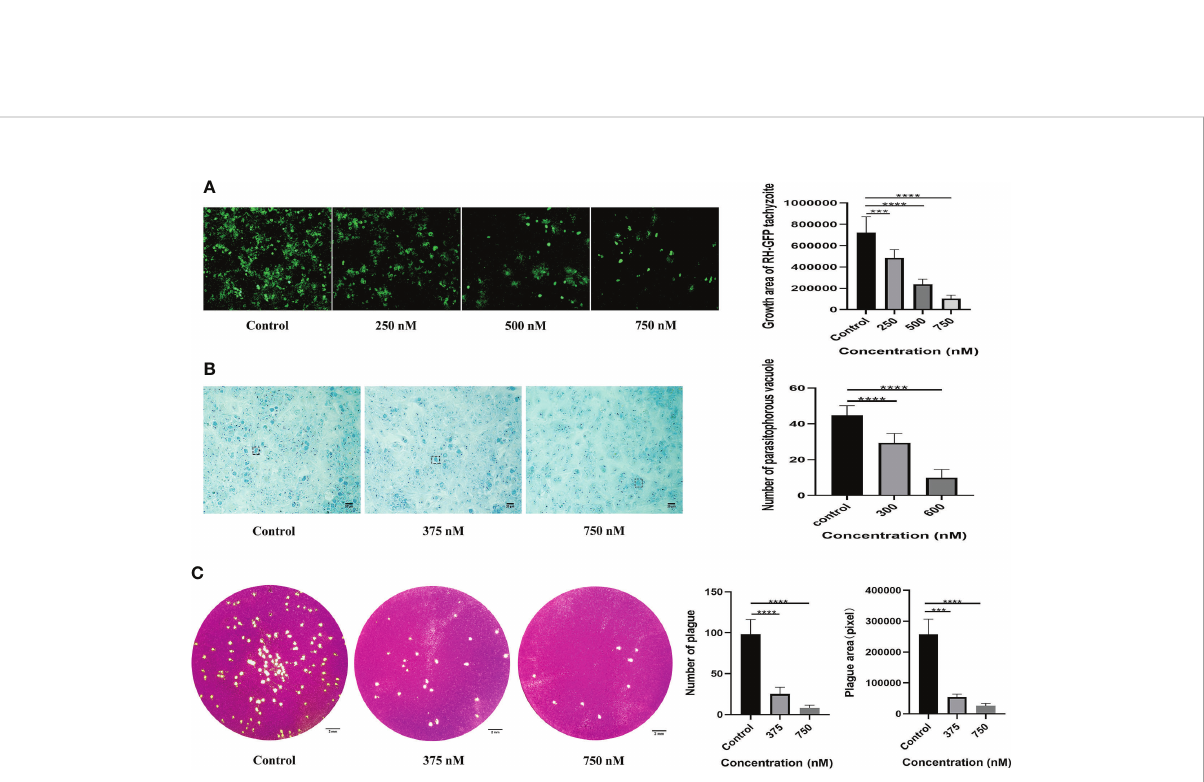
FIGURE 2 Assessing the effect of LBH589 on the proliferation and activity of T. gondii . Infected cells cultured with DMEM were used as negative controls. (A) The fl uorescence area shows the proliferation of T. gondii after incubation with different concentrations of drugs for 48 h. (B) The number of intracellular parasitophorous vacuole in the treated and infected groups. (C) Comparing the overall growth of parasites in the infection group to that of the treatment group via plaque assay. *** P < 0.001, **** P < 0.0001, in comparison with the control. Scale bars: B = 20 m m; C= 2 mm. Each experiment was repeated three times, with three wells of each sample.